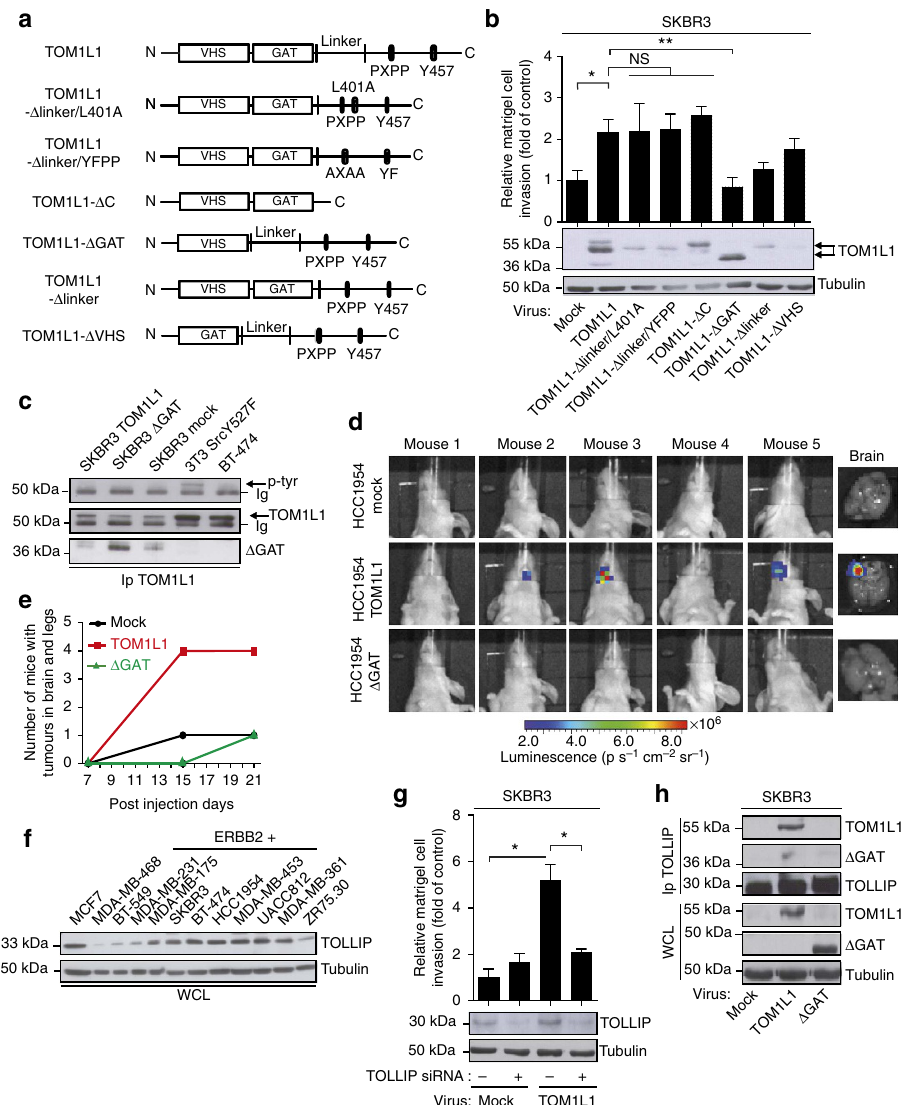
Figure 3 | TOM1L1 pro-invasive activity requires ERBB2-induced interaction of its GAT domain with TOLLIP. ( a ) Schematic showing TOM1L1 and the different mutants used in the study. ( b ) Upper panel: invasion of SKBR3 cells infected with the indicated viruses was assessed in Boyden chambers with matrigel. The histogram shows the invasion ratio normalized to the control value after 48h of invasion ( n ¼ 4). Mean ± s.e.m * P o 0.05, ** P o 0.01, NS, no significant (Student’s t -test). Lower panel: western blots showing the expression of the various TOM1L1 mutants in SKBR3 cells. ( c ) Lysates from BT-474, 3T3-SRCY527F and SKBR3 cell lines expressing the indicated constructs were immunoprecipitated with an anti-TOM1L1 antibody and blotted as indicated. Note that only the 3T3-SRCY527F cell lysate shows a band corresponding to p-tyr above the Ig band. ( d , e ) In vivo metastasis assay: luciferase- expressing HCC-1954 cells infected as indicated were injected in mice hearts (left ventricle). At the indicated times, mice were injected intraperitoneally with luciferine and imaged. ( d ) Mice imaging show higher bioluminescence signal in the brain of mice injected with TOM1L1-expressing cells compared with mock or D GAT-expressing cells (day 21 post injection). Right panel shows representative images of mice brains in each condition. ( e ) Quantification in time of the number of mice exhibiting bioluminescence signals in brain or legs. Note that bioluminescence signals are detected earlier and in more mice (day 15) when injected with cells that express TOM1L1 than with control cells (mock) or the D GATmutant. ( f ) Western blot analysis of TOLLIP expression in 12 breast cancer cell lines. Note that TOLLIP is preferentially expressed in ERBB2 þ cell lines. Lysates used were the same as in Fig. 1d. ( g ) Upper panel: invasion of SKBR3 cells infected as indicated and transfected twice with control ( (cid:2) ) or TOLLIP siRNAs ( þ ) was assessed and quantified as in b ( n ¼ 5). Mean ± s.e.m * P o 0.05 (Student’s t -test). Lower panel: the efficiency of TOLLIP silencing was confirmed by western blot analysis of TOLLIP expression in the transfected cells. ( h ) Whole cell lysates of SKBR3 cells infected with indicated viruses were immunoprecipitated with an anti-TOLLIP antibody and immunoblotted as